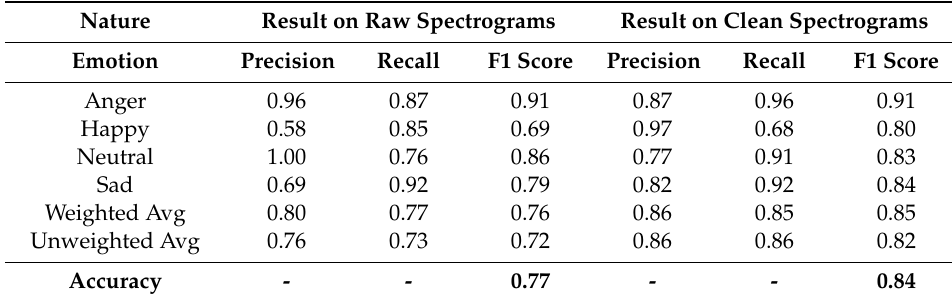
Table 2. Training performance of the proposed DSCNN model on raw and clean spectrograms using IEMOCAP.